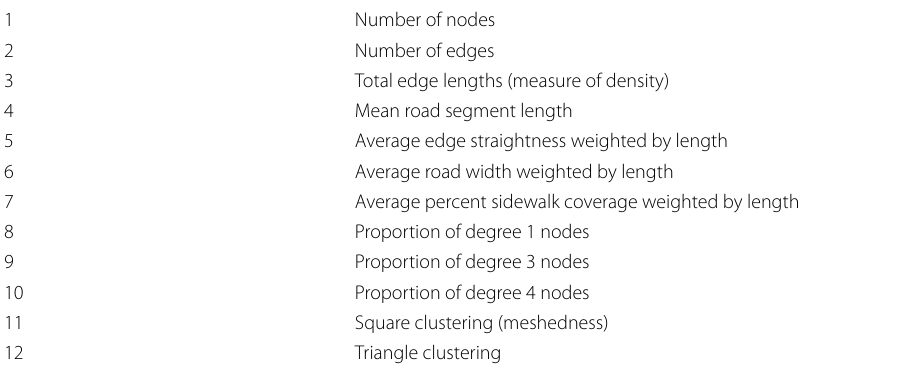
Table 2 Measures collected for each ego-centric